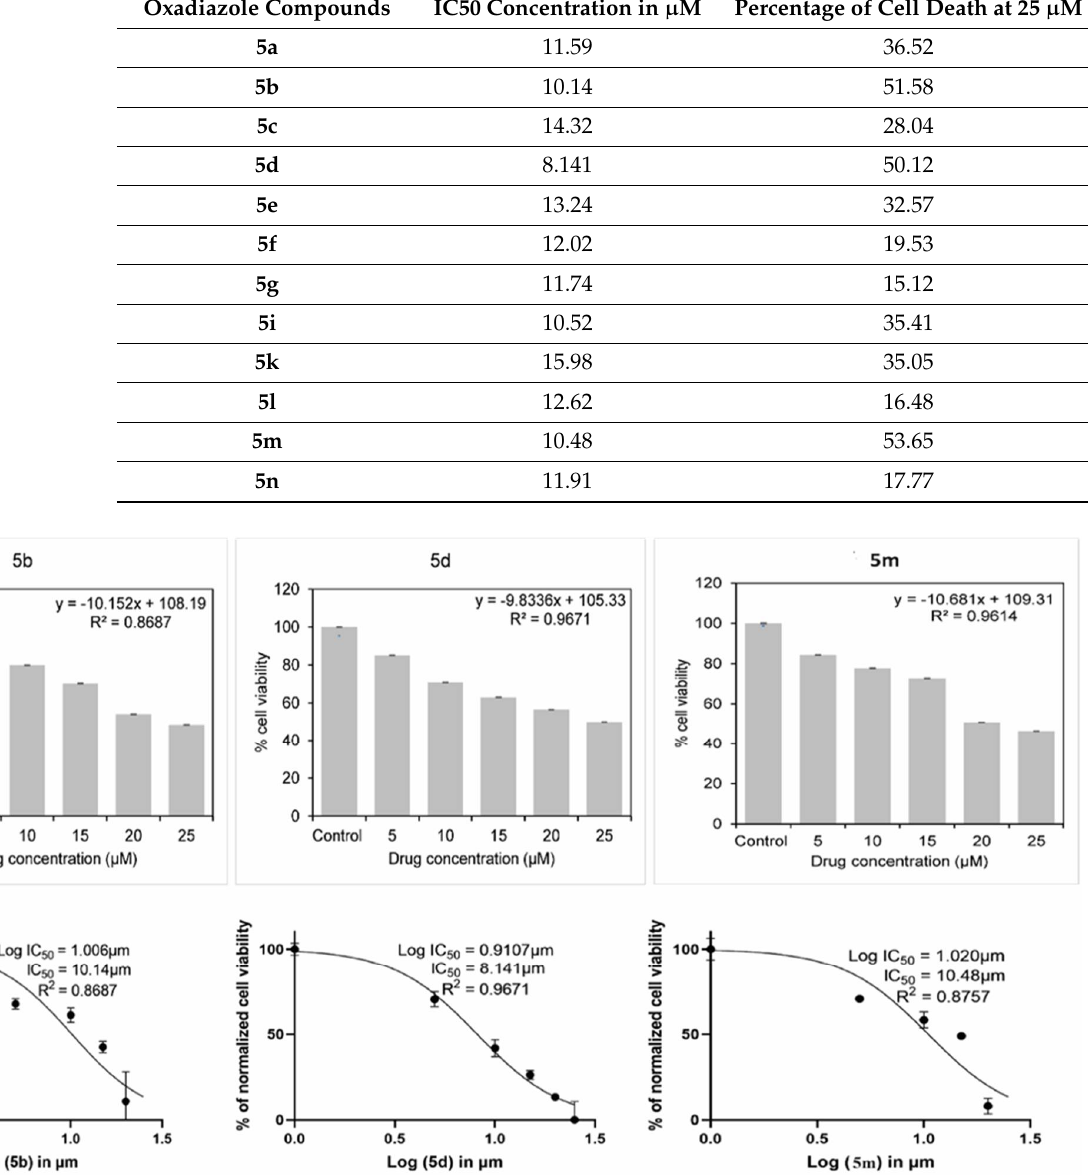
Table 7. IC 50 values and % cell death for all the newly synthesized compounds.